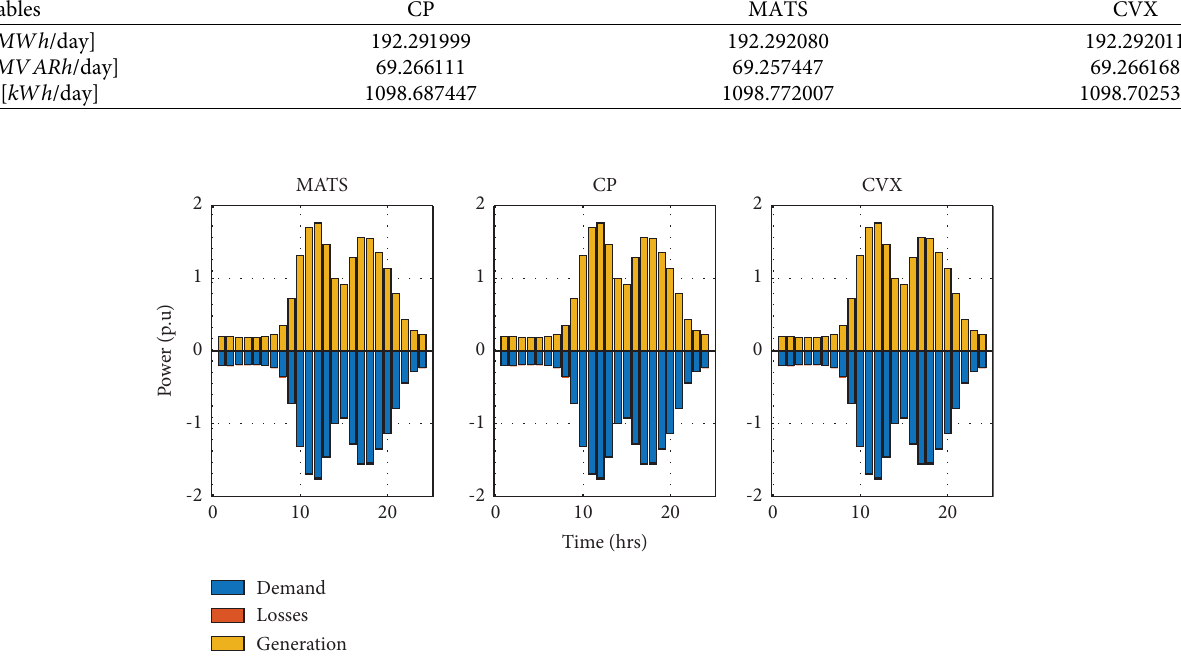
Figure 2: Power balance for simulation